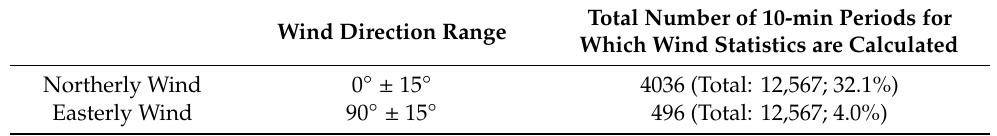
Table 5. Wind direction range and total number of data values.